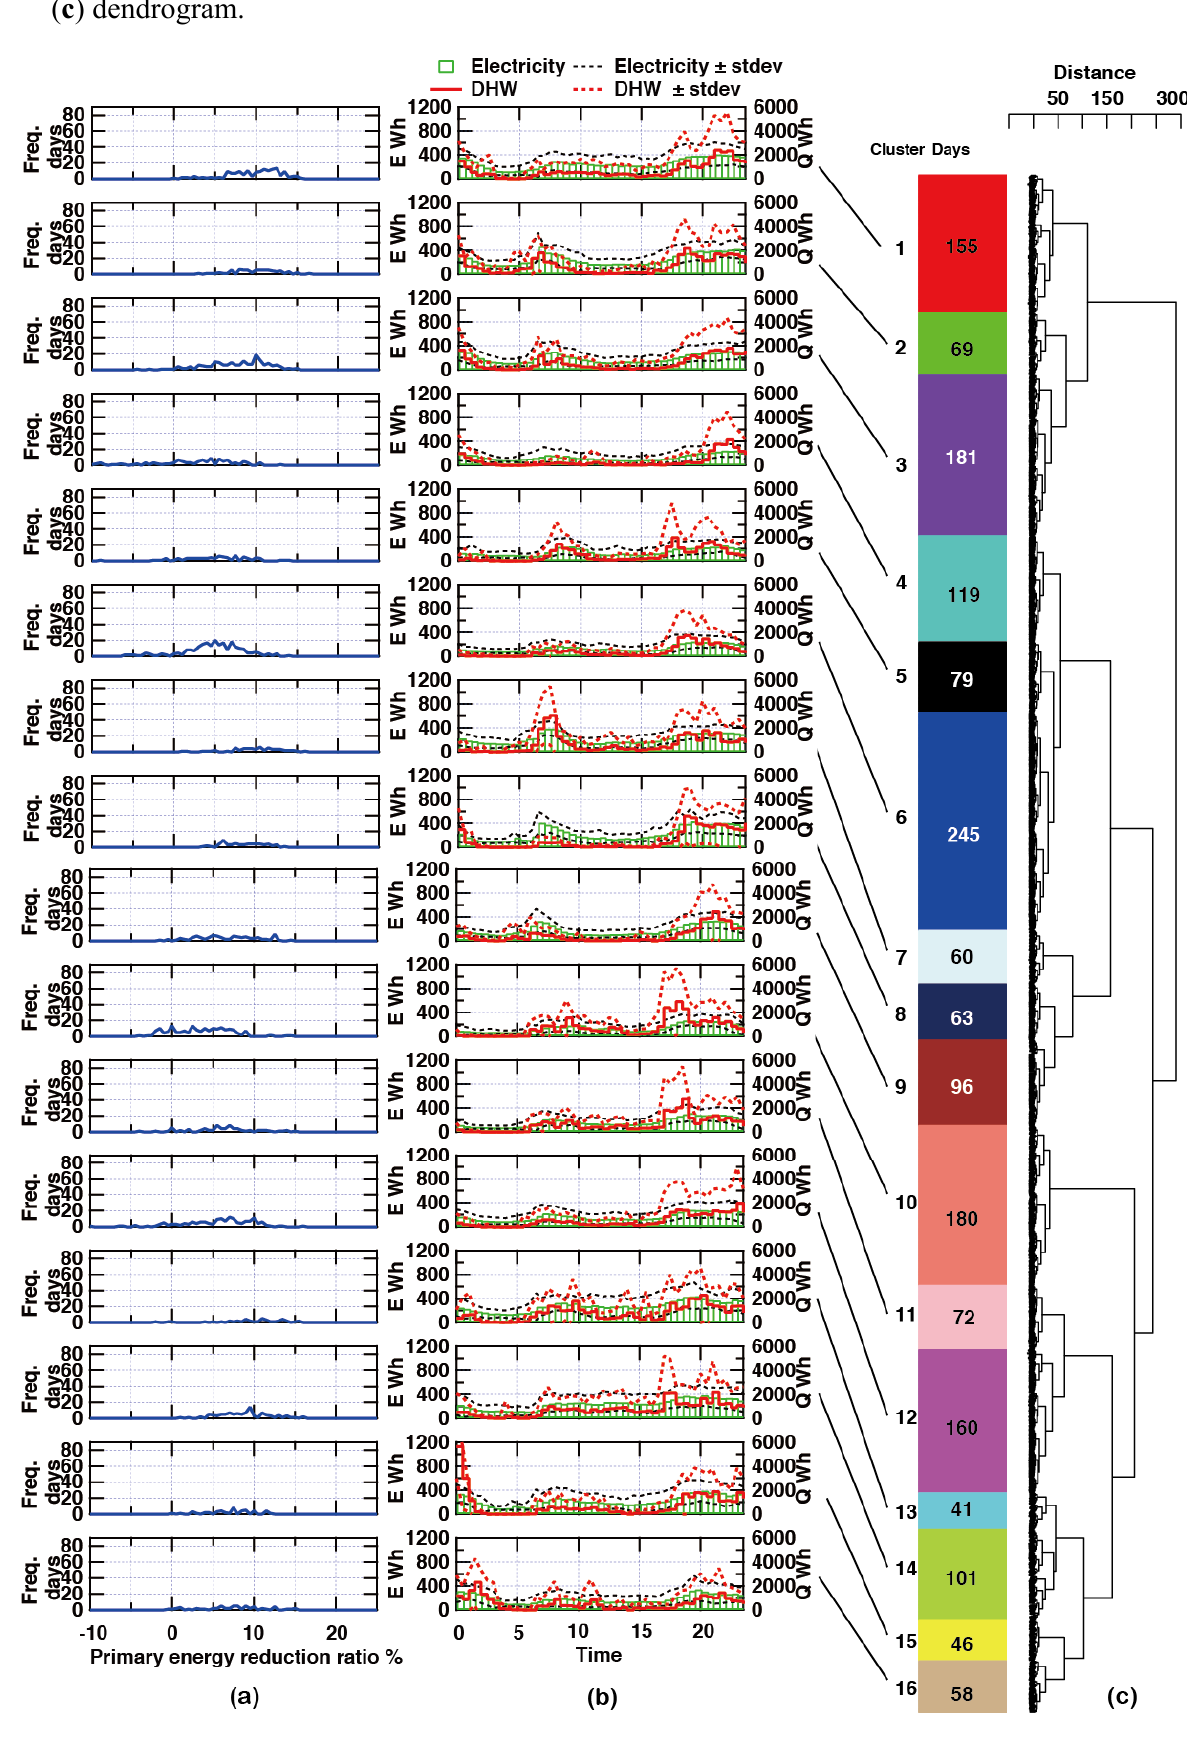
Figure 13. Clusters in Group F. ( a ) primary energy reduction ratio; ( b ) demand patterns; ( c )